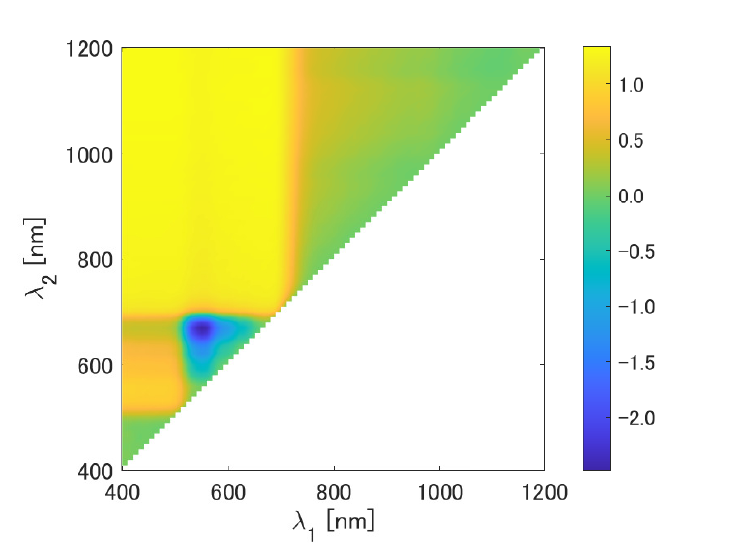
Figure 2. k opt as a function of λ 1 and λ 2 .